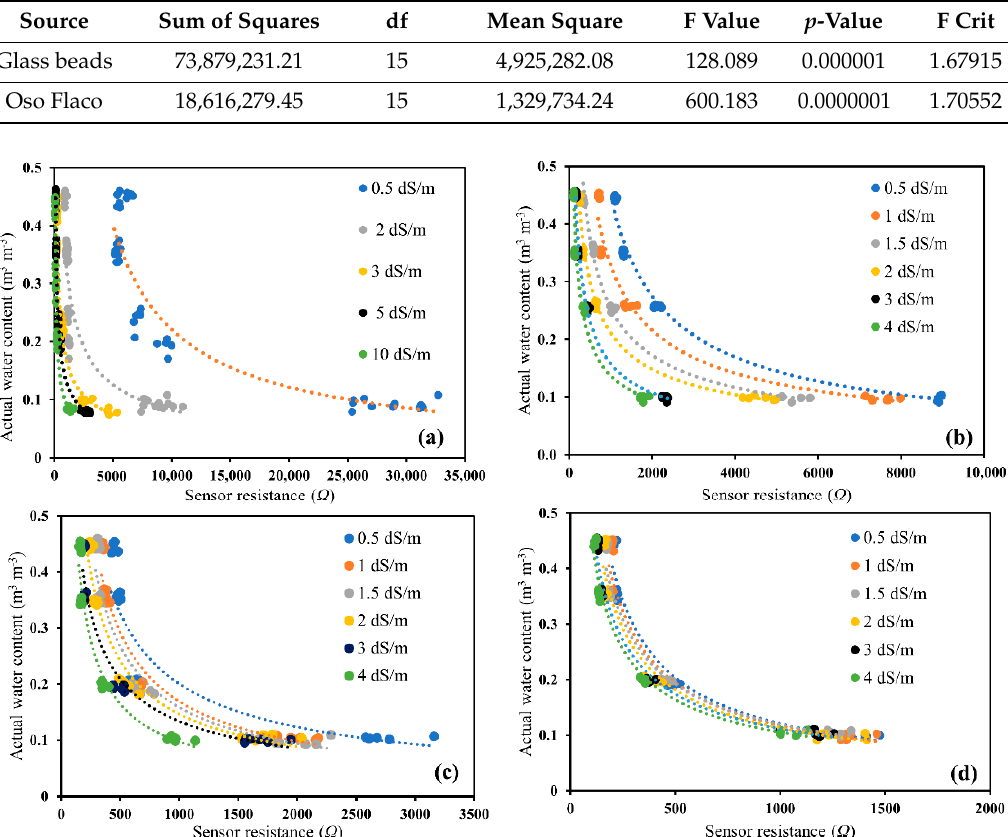
Figure 3. Changes in sensor output resistance ( 𝛺 ) over a range of actual water content (volumetric water content) and solution electrical conductivity (EC w ) in ( a ) glass beads, ( b ) Oso Flaco sand, ( c ) Columbia loam, and ( d ) Yolo clay loam.